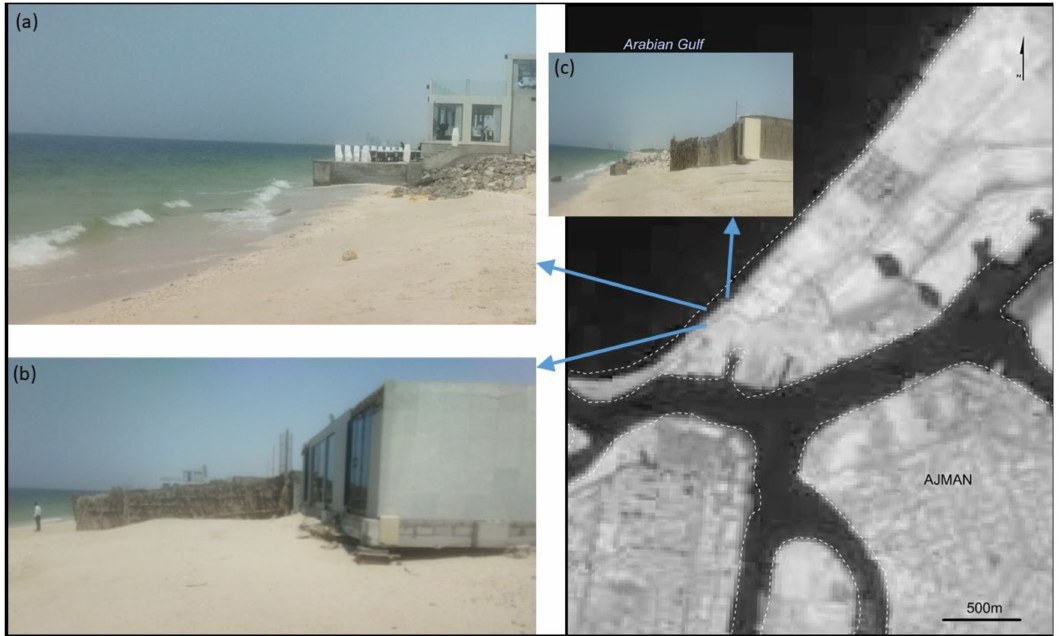
Figure 13. Landsat 7 Band 5 image dated 25th November 2021 showing the northern part of Ajman front coast. The dashed line in white denotes the shoreline position in 1990. Insets ( a – c ) are pictures taken in the field displaying the nature of coastal retreat along the